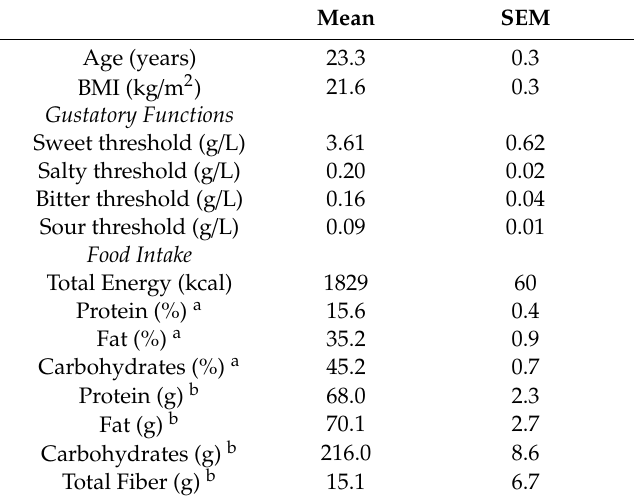
Table 3. Baseline characteristics, energy and nutrient intake, and gustatory functions (taste thresholds, PROP responsiveness, and FPD) presented as mean, standard error of study participants. Mean SEM Age (years) 23.3